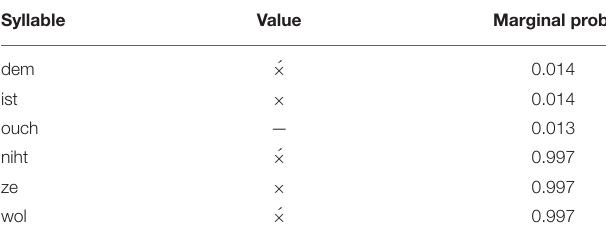
TABLE 10 | Example (10), average probability 0.505.